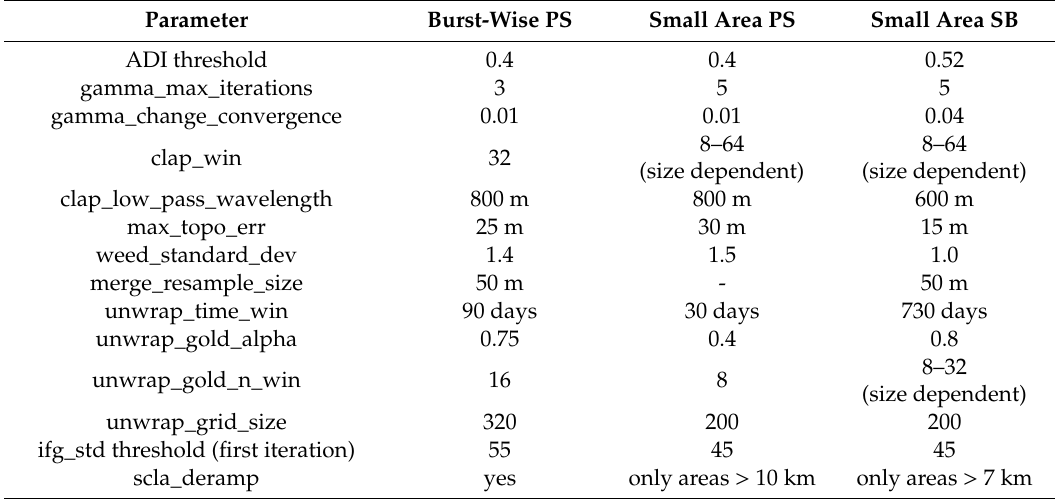
Table2. SelectedSTAMPSmultitemporalInSAR(MT-InSAR)parametersusedwithinIT4S1automatised processing